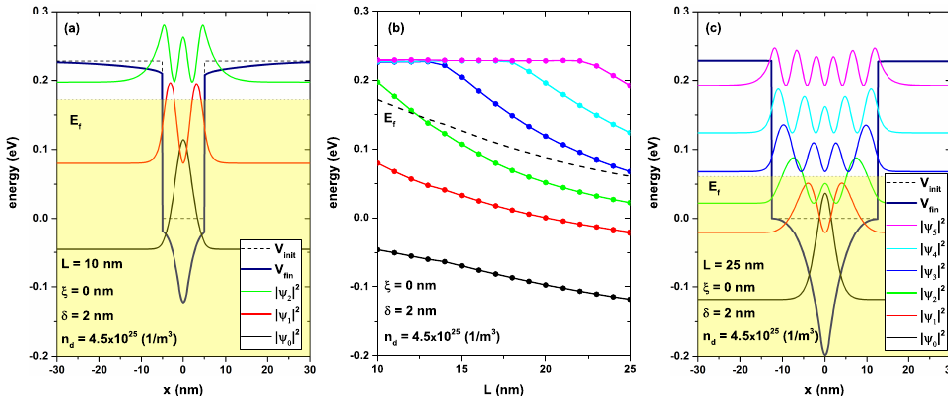
Figure 5. ( a , c ): Self-consistent potential V ( x ) with a solid line in navy color, and electron confinement potential V c ( x ) as a black dashed line. Figure ( a ) corresponds to L = 10nm and Figure ( c ) to L = 25nm; for both figures, the parameters ξ = 0, n d = 4.5 × 10 25 (1/m 3 ), and δ = 2nm were set. In both figures, the probability densities of all confined states were included. The shaded region indicates the occupied states, and the maximum of this region corresponded to the energy Fermi level in the system. Figure ( b ) represents the lowest confined energy levels as a function of the well width; the dashed line is the self-consistent Fermi level E f